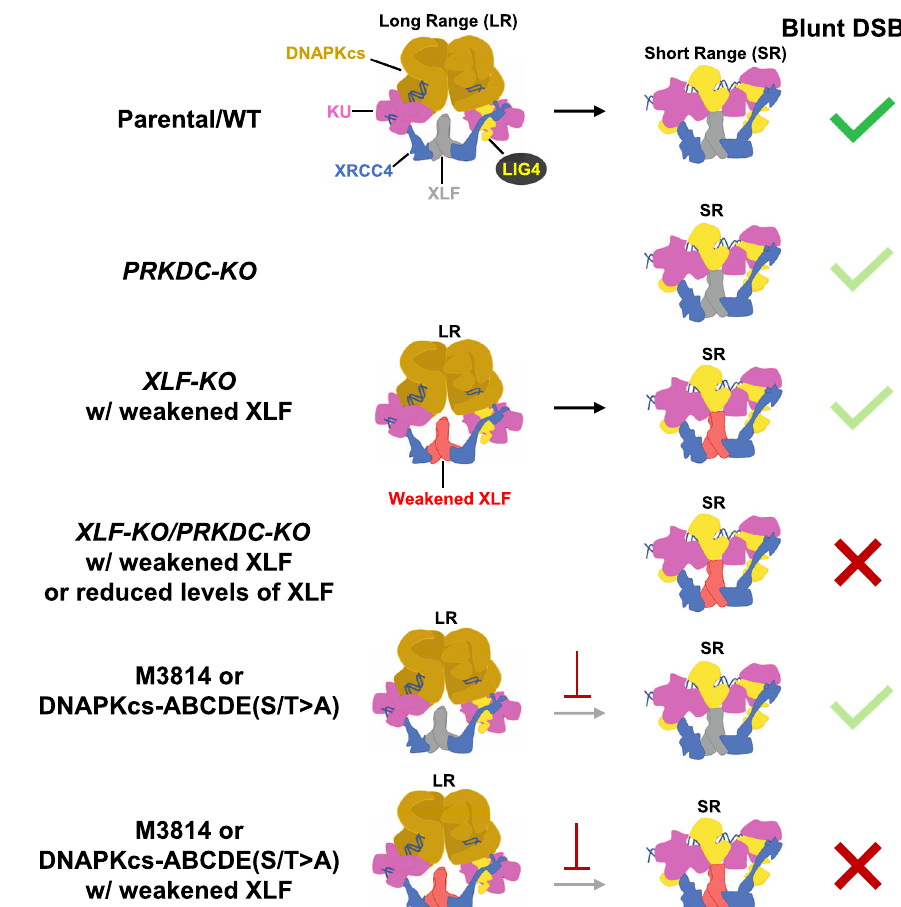
Fig. 7 Summary. Model for the DNAPKcs LR C-NHEJ complex being important to stabilize a weakened XLF to transition into a functional SR complex to facilitate blunt DSB EJ. Illustrations adapted from published cryo-EM structures described in the text. Light green checkmark depicts a partial defect, whereas a red X denotes a marked loss of blunt DSB